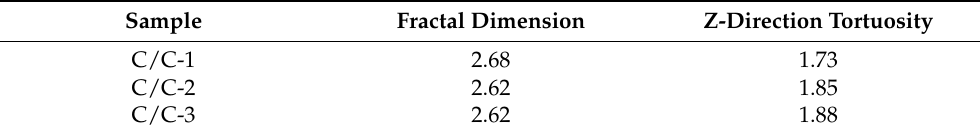
Table 1. The structural parameters of the connected pores in the porous C/C composites.